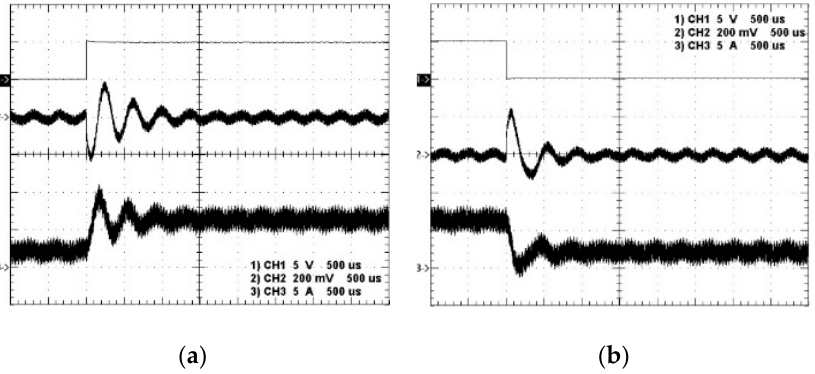
Figure 12. Waveforms based on the traditional PWM control strategy: (1) load enable; (2) AC output voltage; (3) inductor current, due to ( a ) from 25% to 75%; ( b ) from 75% to 25%.